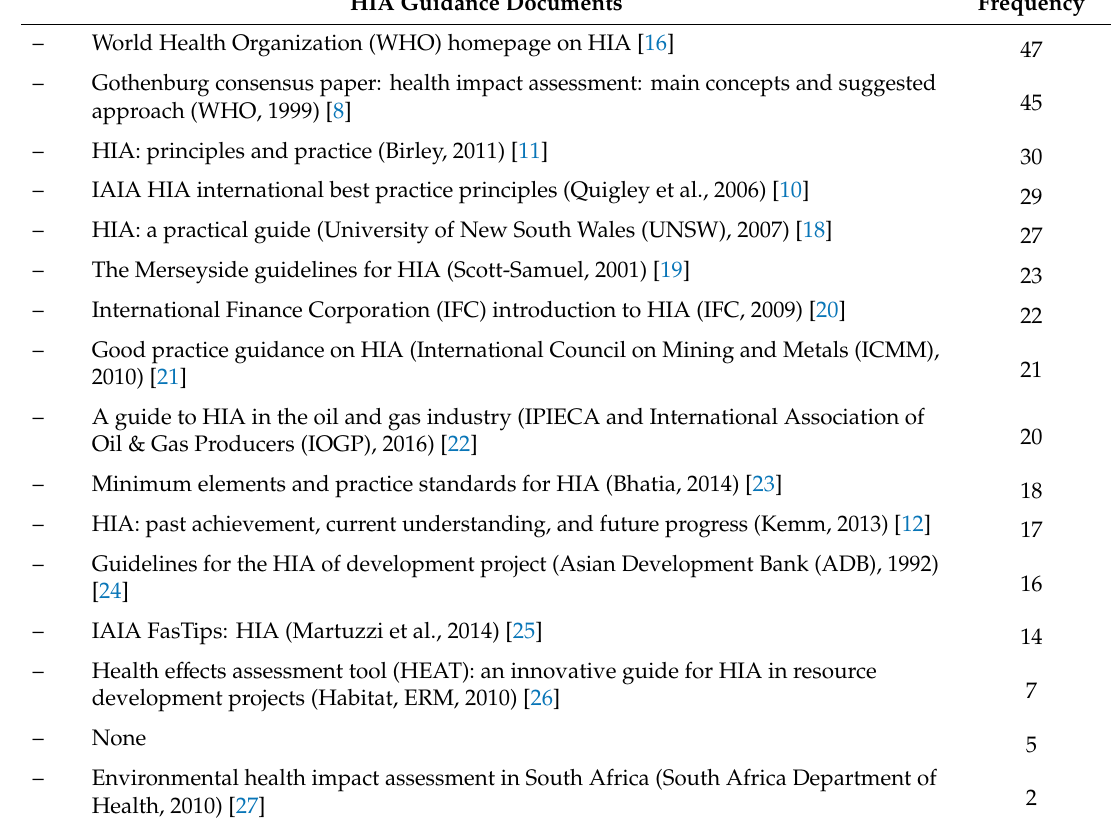
Table 1. Preferred HIA source documents guiding HIA